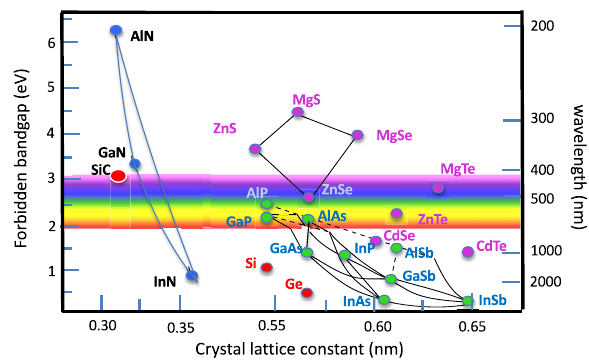
Figure 1: Bandgap map of major